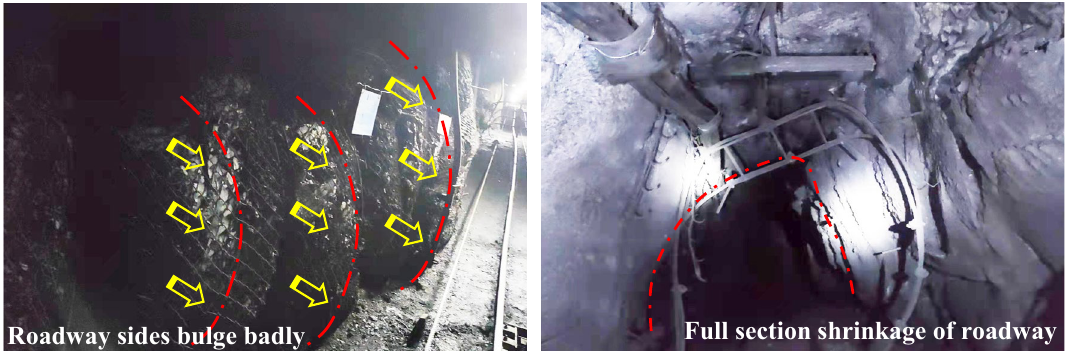
Figure 3. Large deformations and failures for main